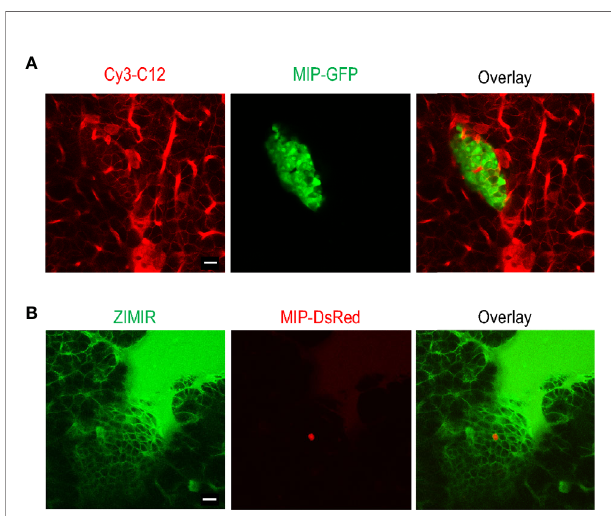
FIGURE 3 | Labeling mouse islet cells in the intact pancreas via dye infusion through the splenic artery. (A) Confocal fl uorescence images of a pancreas (MIP-GFP) post-infusing Cy3-C12 for 5 min into the exocrine tissue. (B) Confocal fl uorescence images of a pancreas (MIP-DsRed) post-infusing ZIMIR. The scarce DsRed labeling was likely due to the low penetrance of MIP-DsRed transgene in this mouse. Scale bar = 20 µm.